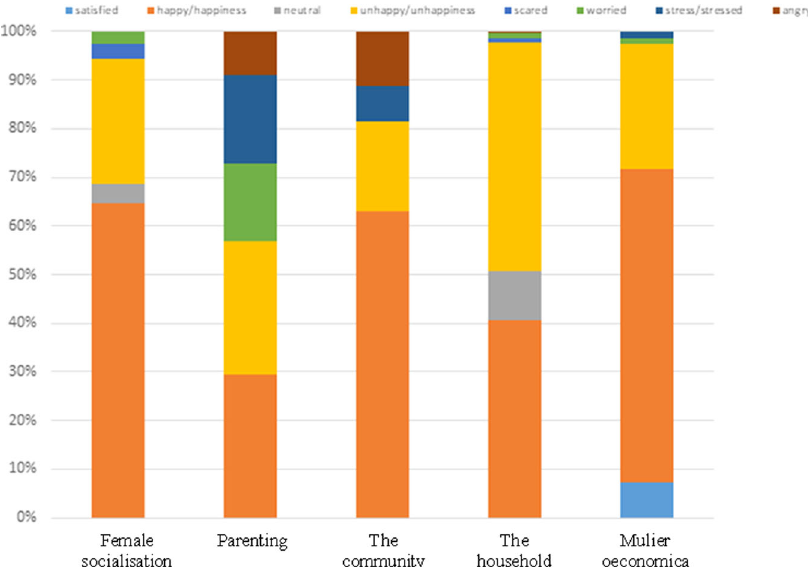
Fig. 7 Distribution of wellbeing words in each theme: this graph illustrates the relative frequency, within each theme, of the adjectives or nouns describing participants ’ mood or cognitive assessments of their lived experiences. It conveys the mood associated with each